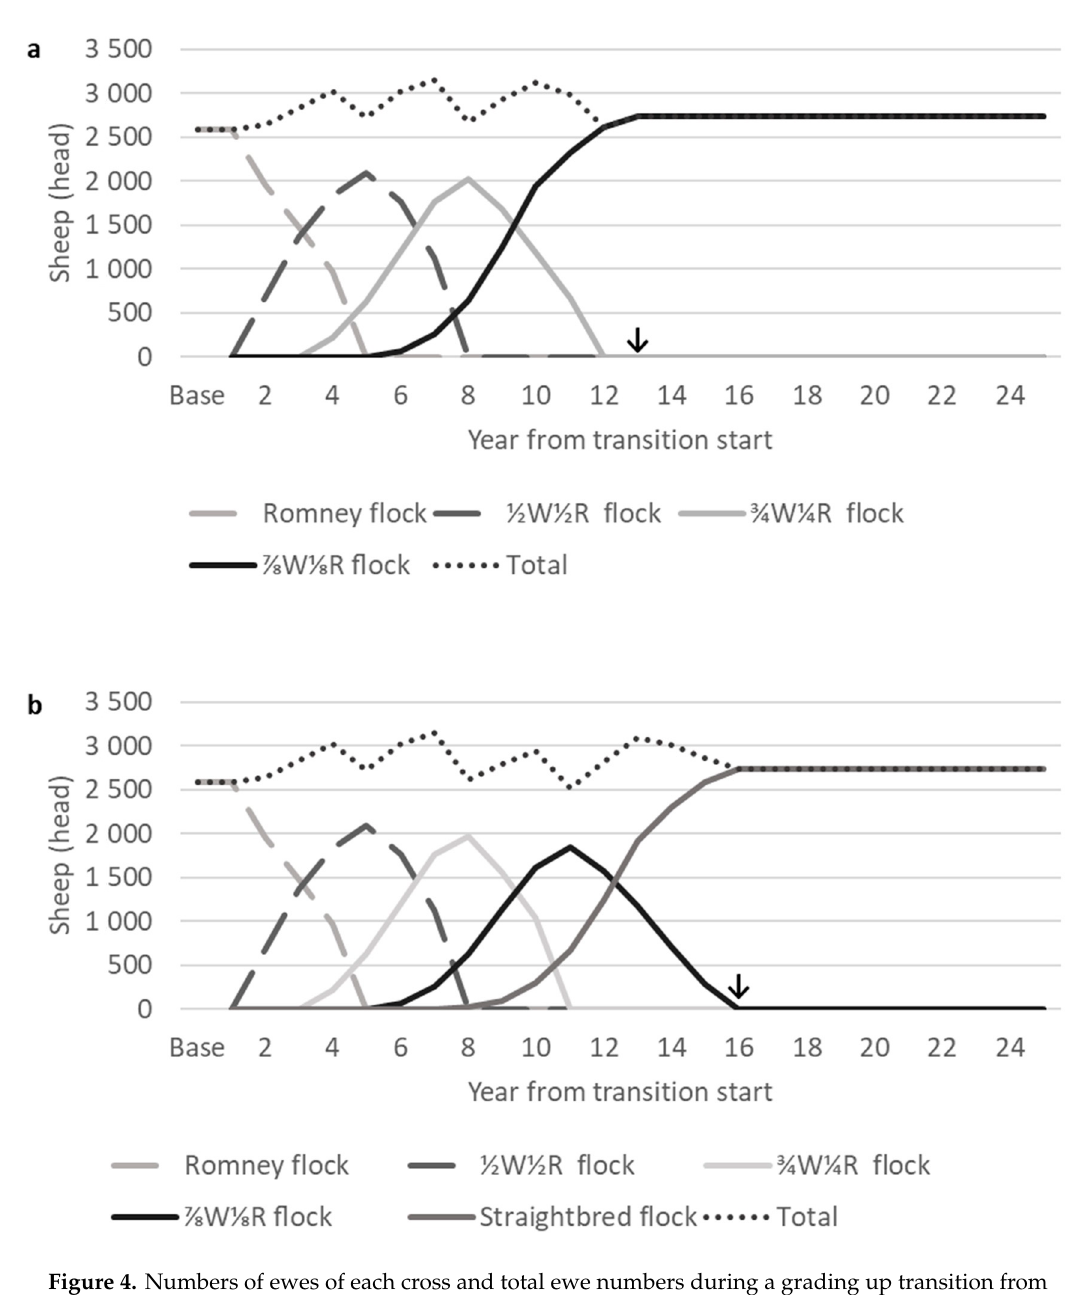
Figure 4. Numbers of ewes of each cross and total ewe numbers during a grading up transition from base Romney to either ( a ) 7 / 8 Wiltshire 1 / 8 Romney or ( b ) straightbred. ↓ Where the grading up transition period has finished and the desired final cross flock (either 7 / 8 W 1 / 8 R or straightbred) has reached an equivalent feed demand to the base Romney flock.